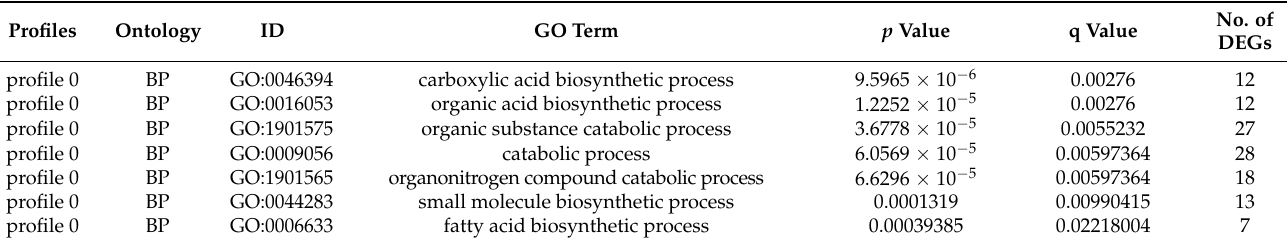
Table 2. GO enrichment of significant profiles from the STEM